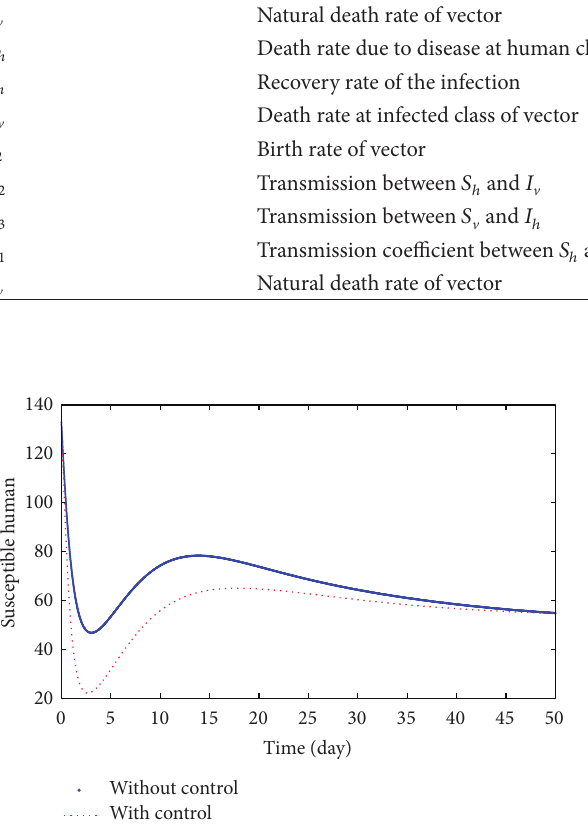
Figure 2: The plot shows the population of susceptible human with and without control.